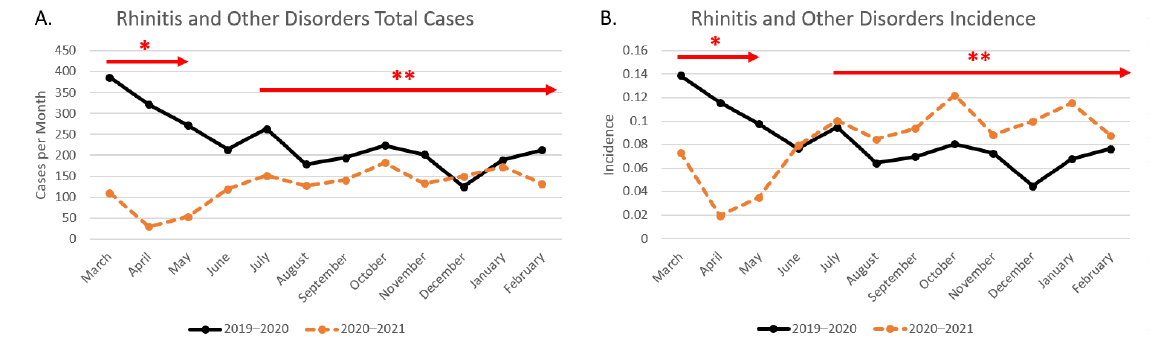
Figure 3. Total rhinitis and other otolaryngological disease cases including university lockdown and state mask mandate. This figure shows the pre-pandemic versus mid-pandemic total cases per month ( A ) as well as the incidence ( B ). * Months during which the academic center was under lockdown (March 2019–early May 2019). ** Months during which Texas mask mandate was effective (July